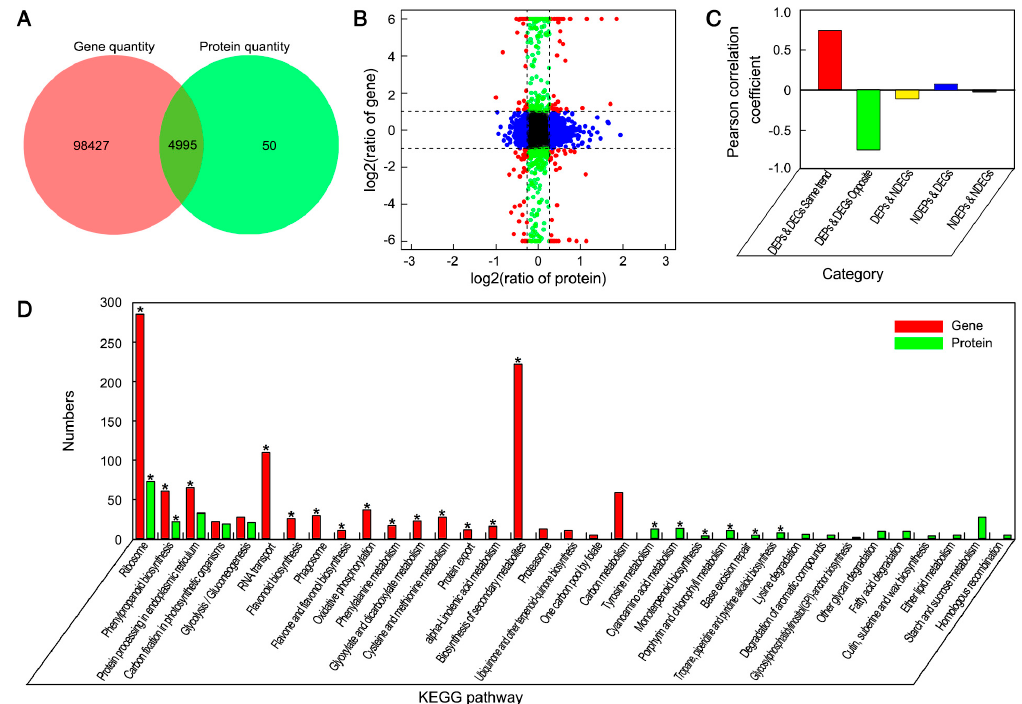
Figure 3. Effects of nano-CaCO 3 treatment on the proteome of P. lactiflora inflorescence stems. ( A ) Venn diagram of the correlation numbers between transcriptome and proteome. The red color represents gene quantity and the green color represents protein quantity. ( B ) Expression ratios from transcriptomic and proteomic profiles based on quantitative proteins and correlated genes. The X axis represents log2-transformed fold change of proteins and the Y axis represents log2-transformed fold change of correlated genes; significant expression changes are indicated by different colors: blue points, proteins only; green points, transcripts only; and red points, both. ( C ) Pearson coefficient distribution of the correlation numbers between transcriptome and proteome in five categories. The X axis represents category, the Y axis represents the Pearson correlation coefficient. ( D ) Pathway enrichment analysis of DEGs and differentially expressed proteins (DEPs). The X axis represents the number of DEGs and DEPs, the Y axis represents the pathway name, the red color represents gene and the green represents protein, and * represents DEG and DEP significantly enriched pathways.